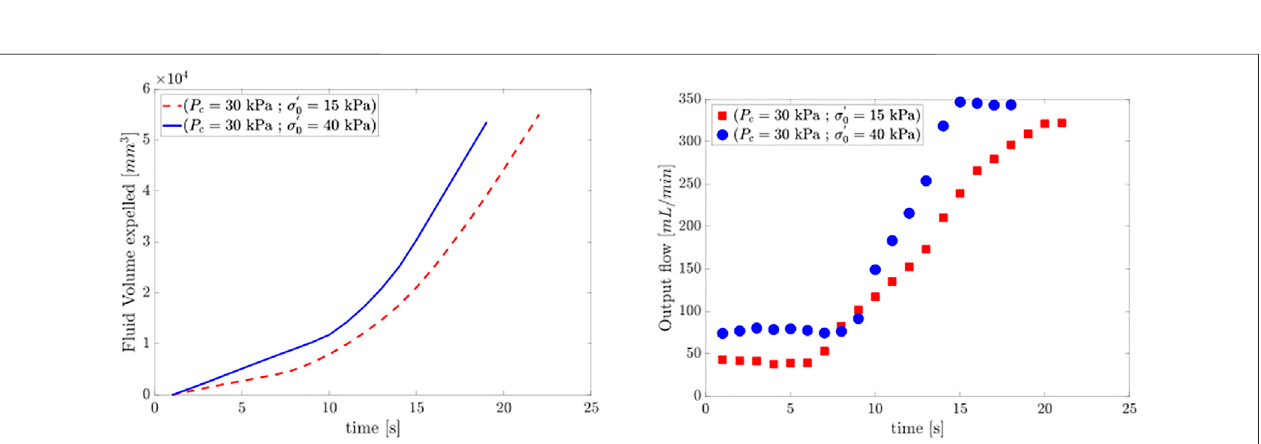
FIGURE 5 | Comparison of fl uid volume expelled and out fl ow for the drainage tests (1) and (2).